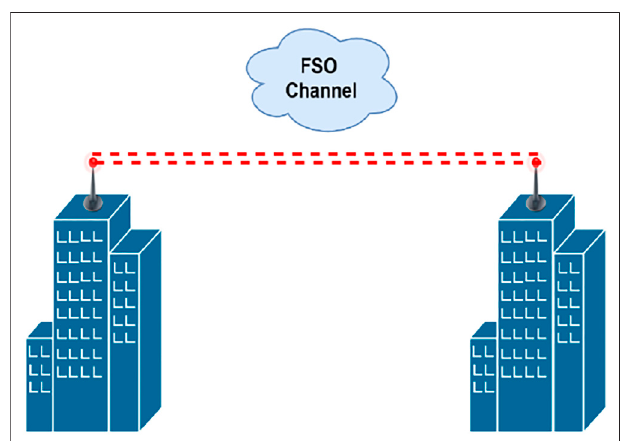
FIGURE 1 | Schematic of terrestrial FSO